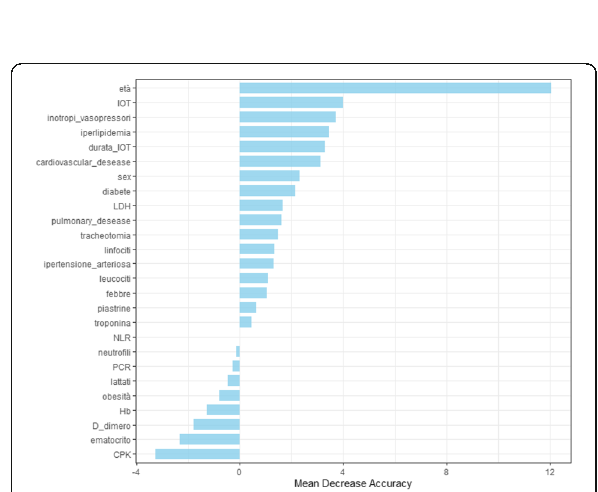
Fig. 1 (abstract A101). See text for A102. COVID19 associated pulmonary aspergillosis (CAPA) in critically ill patients: epidemiology and outcome Caciagli V., Farinelli C., Gatto I., Biagioni E., Busani S., Talamonti M., Girardis M. AOU Policlinico di Modena ~ Modena ~ Italia Correspondence: Caciagli V. J Anesth Analg Crit Care 2022, 2(Suppl 1): A102.